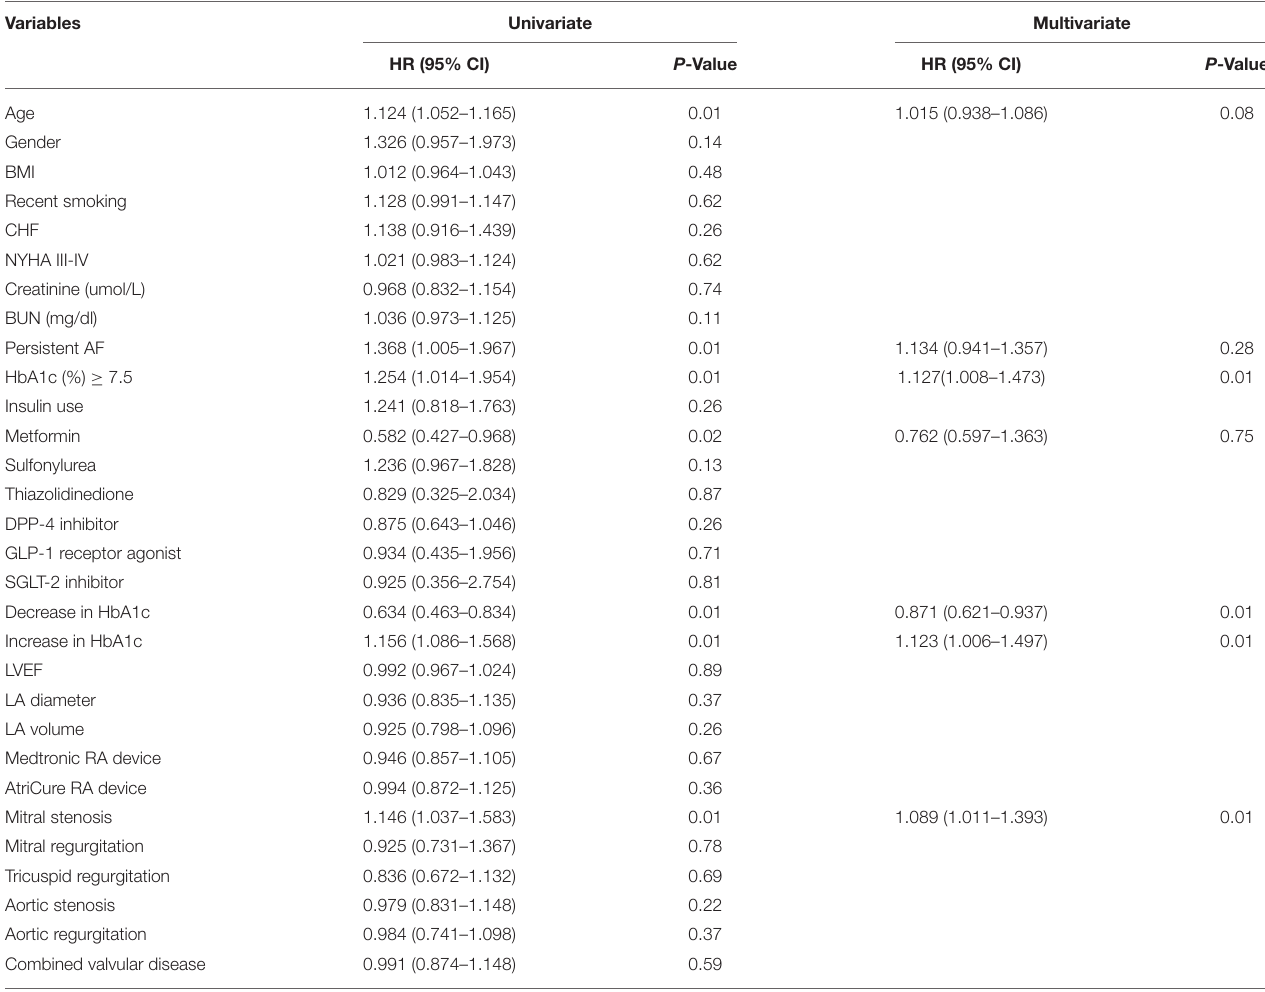
TABLE 6 | Hazard ratios for AF recurrence after